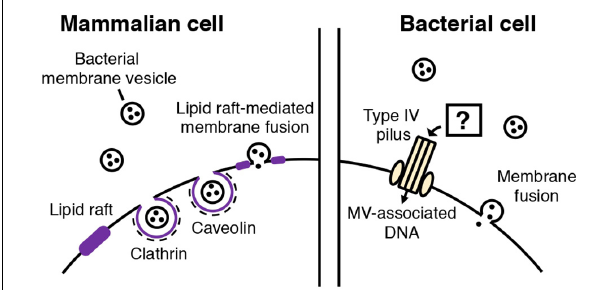
FIGURE 2 | Routes of MV entry into mammalian and bacterial cells. In mammalian cells, bacterial MVs are thought to be internalized through several routes. Cholesterol-rich lipid rafts in the plasma membrane of the mammalian cell mediates MV entry through caveolin-mediated endocytosis or fusion of the lipid raft and bacterial MV. Clathrin-mediated endocytosis is also involved in MV internalization. In bacterial cells, two types of MV entry have been proposed: MV components, such as DNA, may be internalized into bacterial cells through type IV pili, or MVs may also fuse with the cellular membrane of the bacterial cell, depending on the membrane